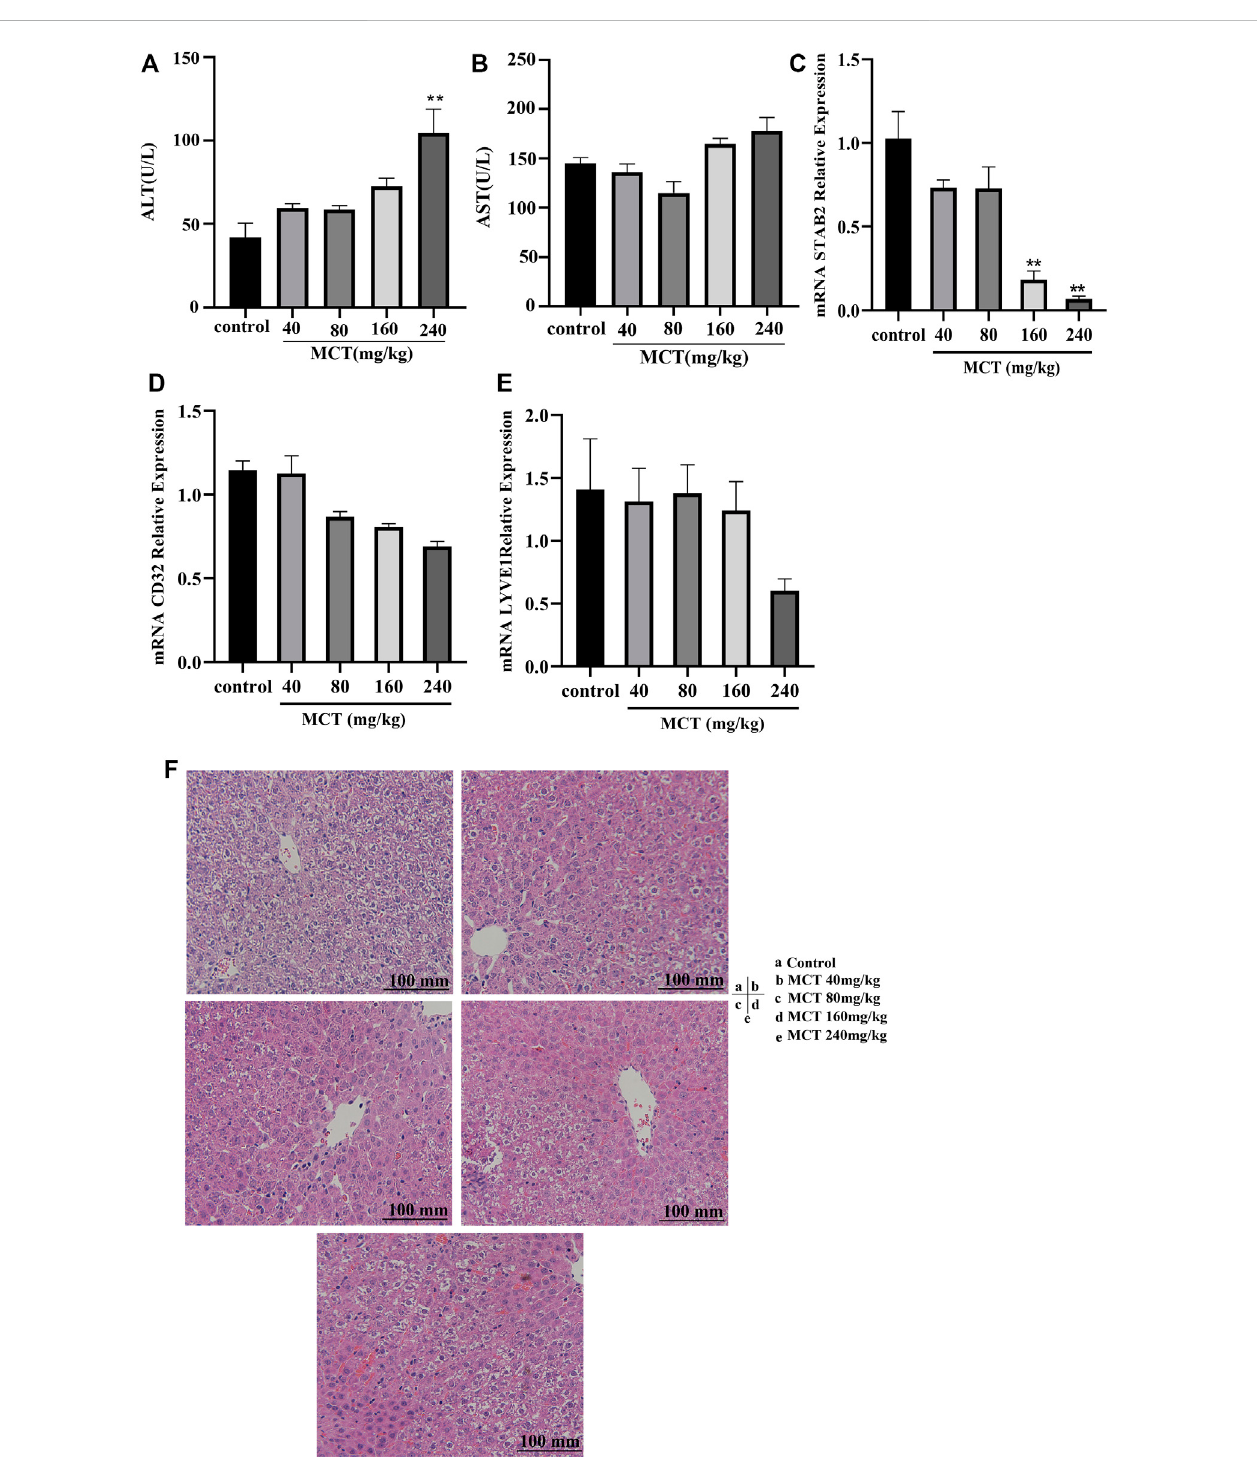
FIGURE 1 Dose-dependent monocrotaline model. Different concentrations of MCT (40, 80, 160, and 240 mg/kg) were administered orally to SD rats for 24 h. Panelsshowlevelorrelativeexpressionof (A) ALT, (B) AST, (C) Stab2, (D) CD32,and (E) Lyve1. (F) HEimagesforlivertissueexposedtodifferentconcentrations of MCT. MCT, monocrotaline; ALT, alanine transferase; AST, aspartate transferase enzyme; LSEC, liver sinusoidal endothelial cell; CD31, cluster of differentiation 31; Lyve1, lymphatic vessel endothelial hyaluronan receptor 1; Stab2, stabilin 2; HE, hematoxylin and eosin stain. Data are presented in the form mean ± SD ( n = 6 rats). * p ≤ 0.05; ** p ≤ 0.01; ***p ≤ 0.001 in comparisons of the MCT-treated group against the control group. Scale bars = 100